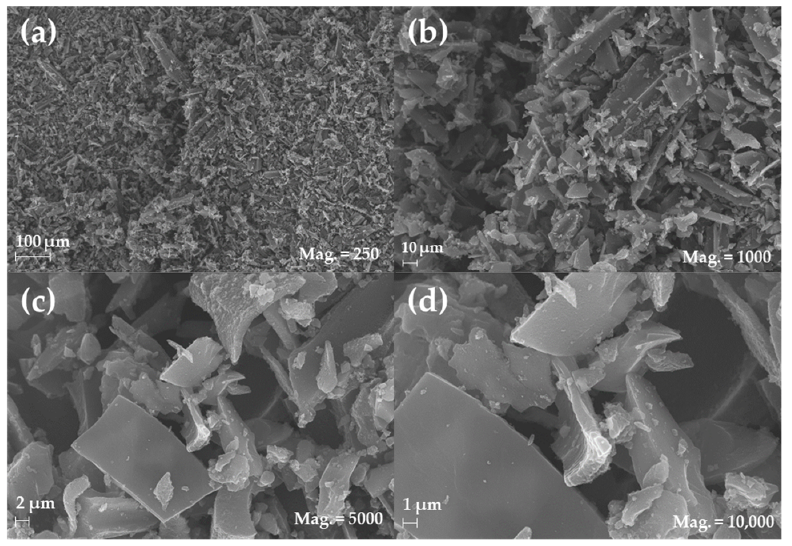
Figure 1. SEM images of 5% Pd/C in magnifications from 250 to 10,000, ( a – d ). All images were taken with following parameters: EHT = 20.0 kV, WD = 8.5 mm, SingalA = InLens.